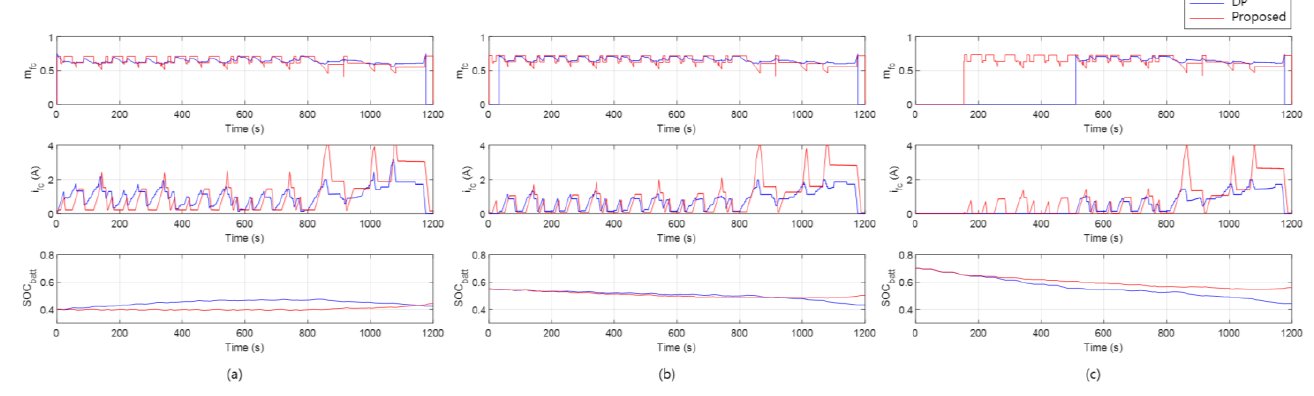
Figure 9. Results of the designed energy management control strategy for the NEDC cycle: ( a ) when the initial SOC is 0.4; ( b ) when the initial SOC is 0.55; ( c ) when the initial SOC is 0.7. Table 4. Trip costs of the DP-based EMS and the proposed EMS.